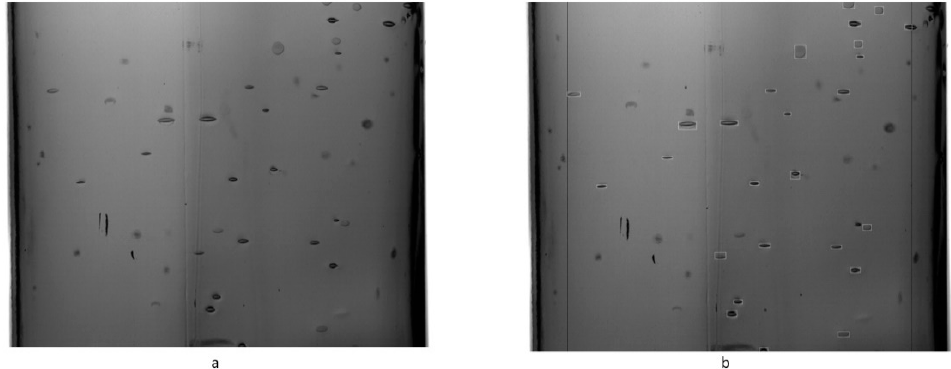
Figure 10. Example of the outcome of the processing pipeline: ( a ) input image; ( b ) output image with the detected seeds (black squared) and blisters (white squared).